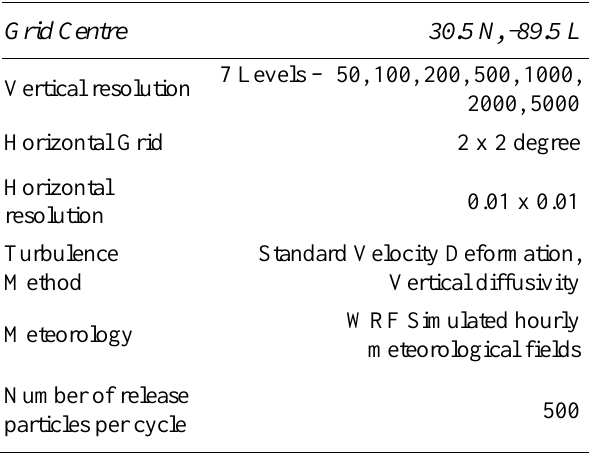
Table 3 : Hysplit dispersion model configuration